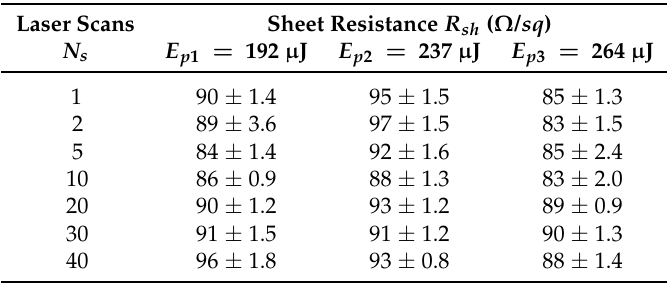
Table 1. Four-point probe measured sheet resistance R sh of areas treated by repeated laser scans for three laser pulse energies E p . No dopant loss (e.g., out-diffusion) occurs, because no significant change of R sh is observable for increasing N s .